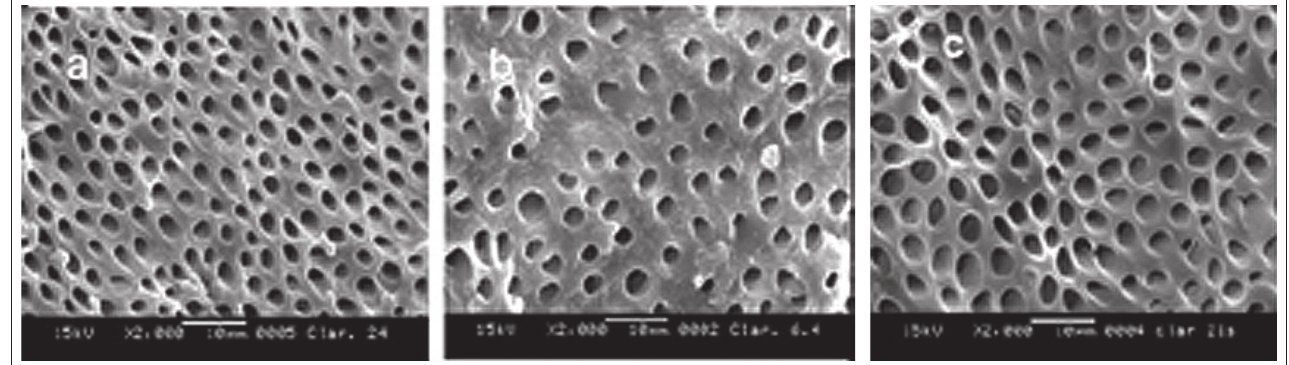
Figure 2. Scanning electron microscope micrographs showing dentin surface without morphological alterations. A: specimen treated with water (Control Group 1). B: specimen treated with chlorhexidine gel (Control Group 2). C: specimen treated with sodium perborate mixed with water (Group 1).